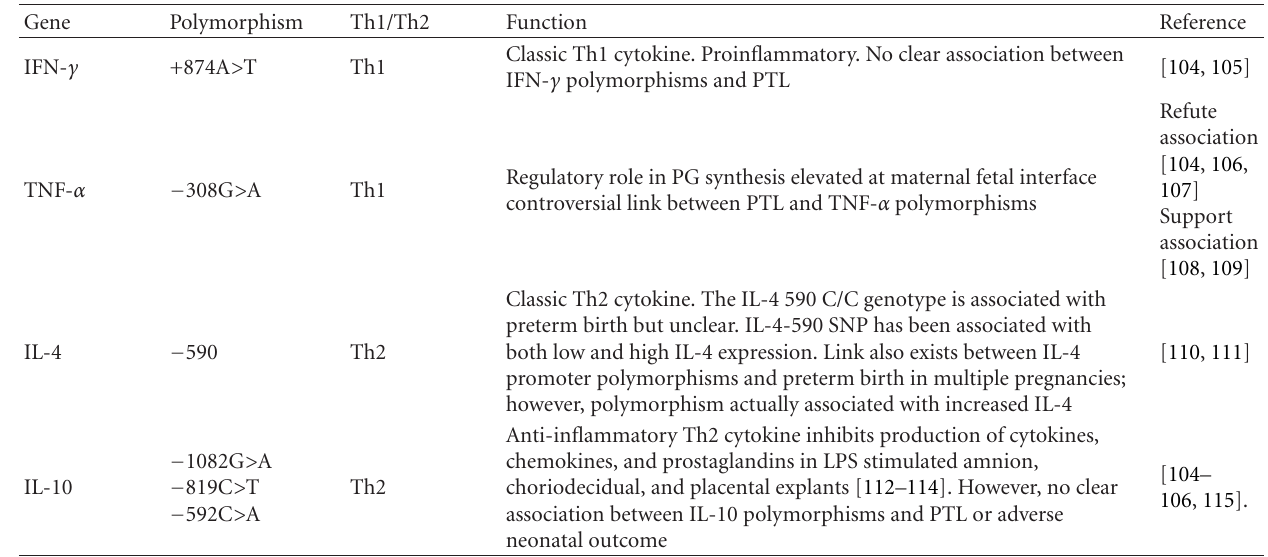
Table 1: Cytokine polymorphism associations with preterm labour